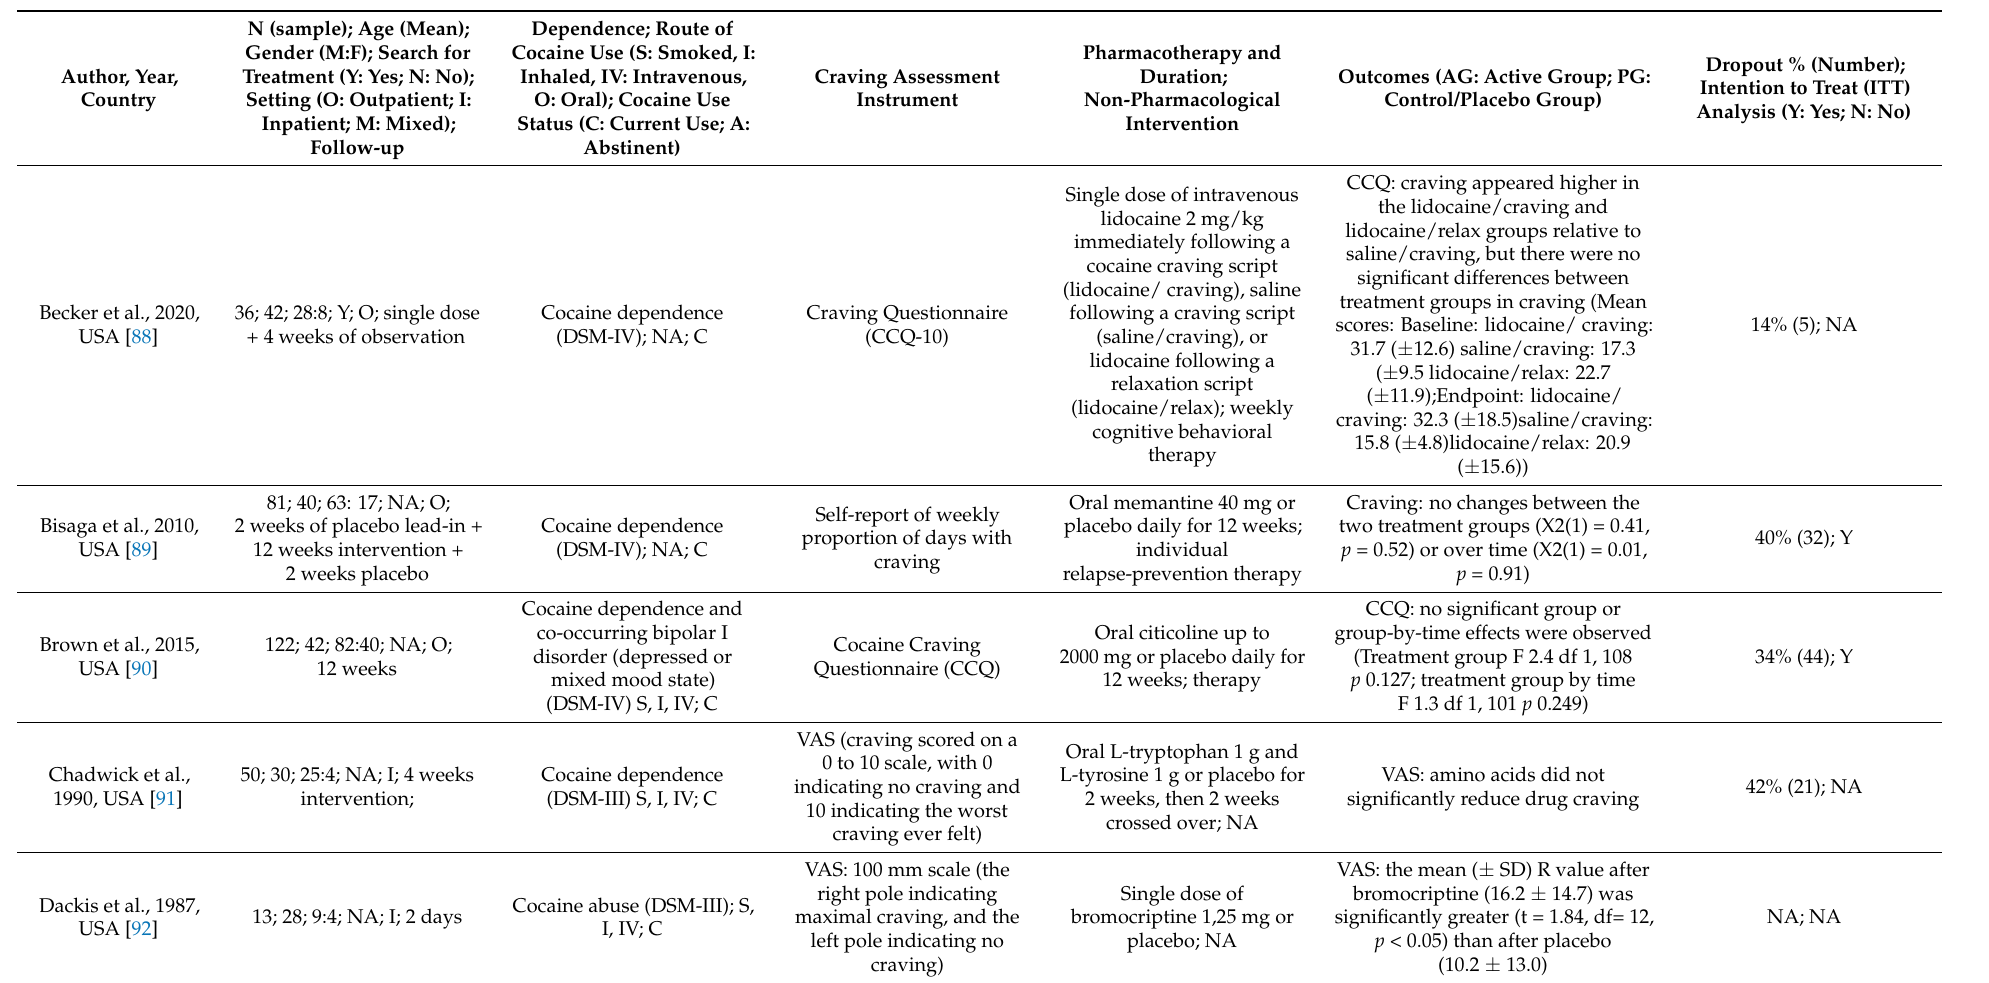
Table 5. Characteristics and main findings of the studies included in the systematic review–Other